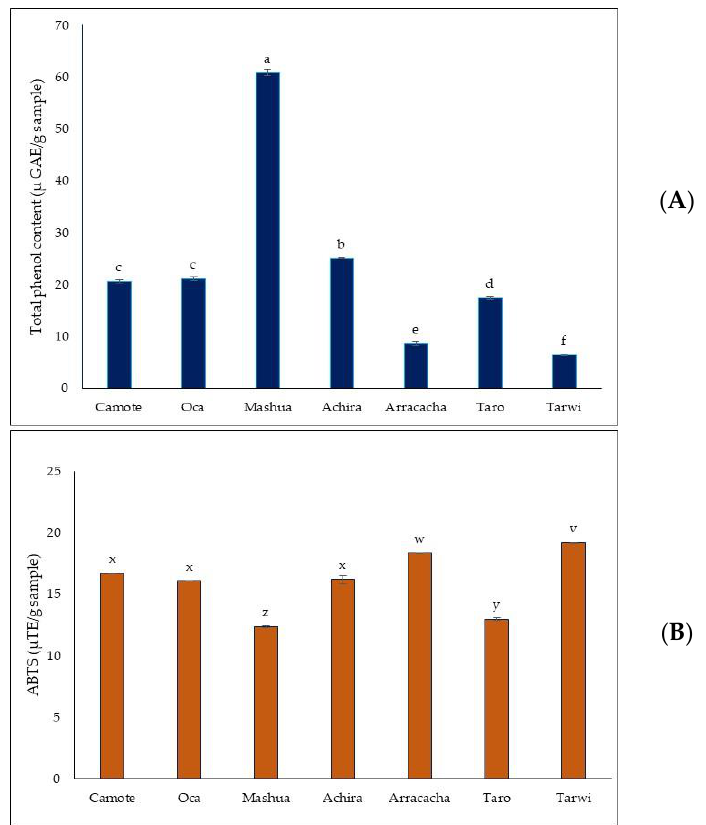
Figure 6. ( A ) Total phenolic content, and ( B ) antioxidant activity by ABTS of flours. Different letters (a, b, c, d) or (x, y, z, . . . ) indicate significant differences between samples.